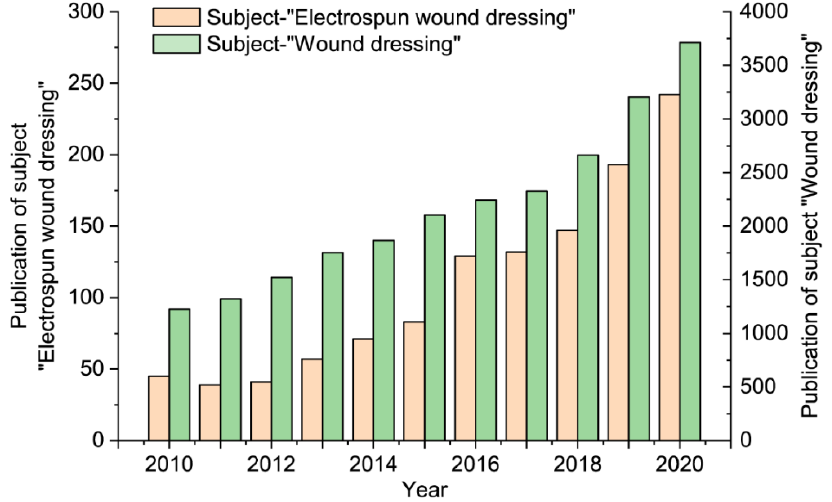
Figure 1. Statistics of literature retrieval on the “Web of Science” platform with the subject of “Wound dressing” and “Electrospun wound dressing”,